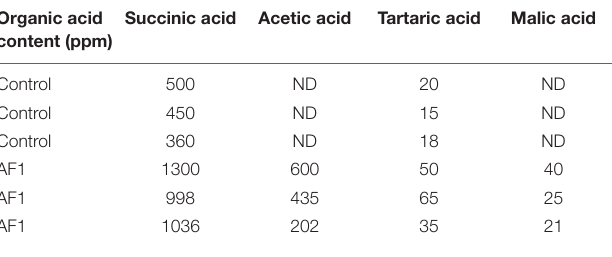
TABLE 2 | Quantification of organic acid content in AR11 suspension culture.